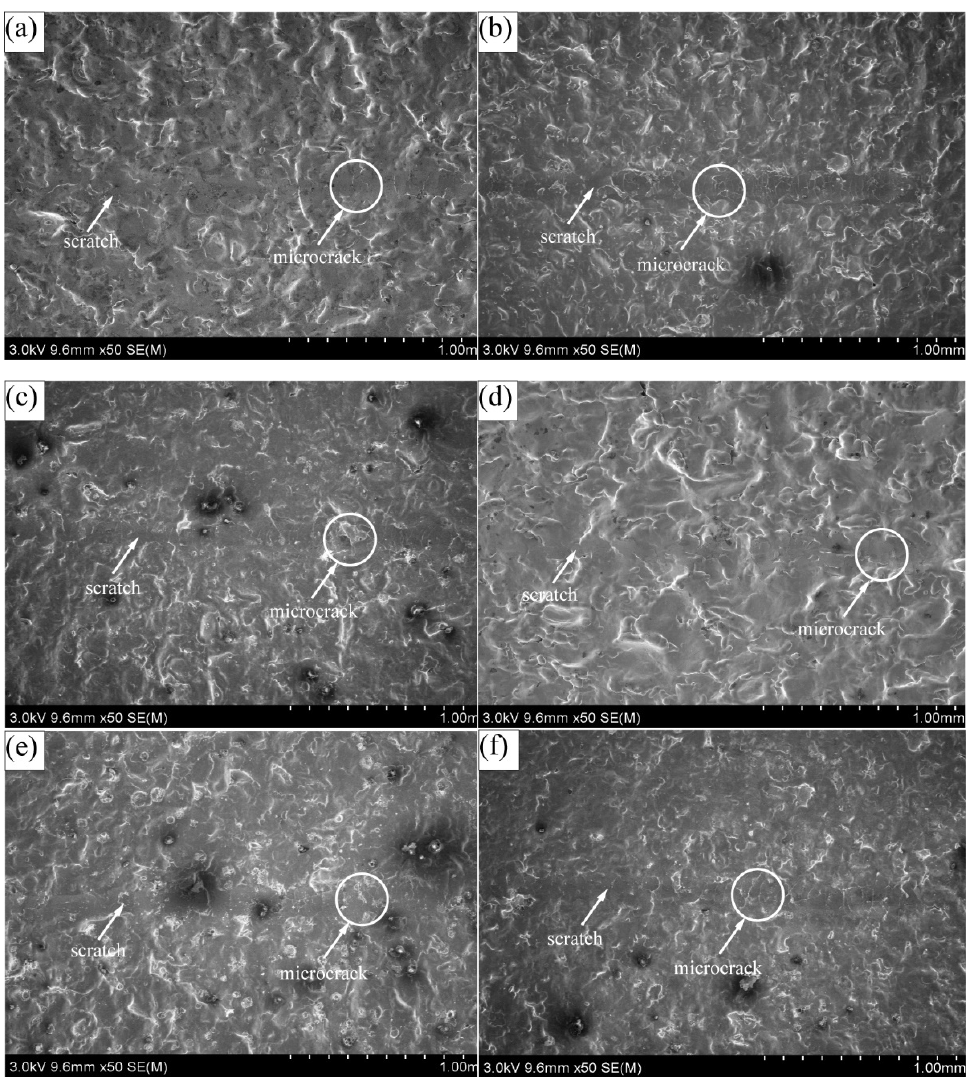
Figure 7. Adhesion of composite coatings with different particle concentrations prepared on 45 steel substrates through scanning electrodeposition.